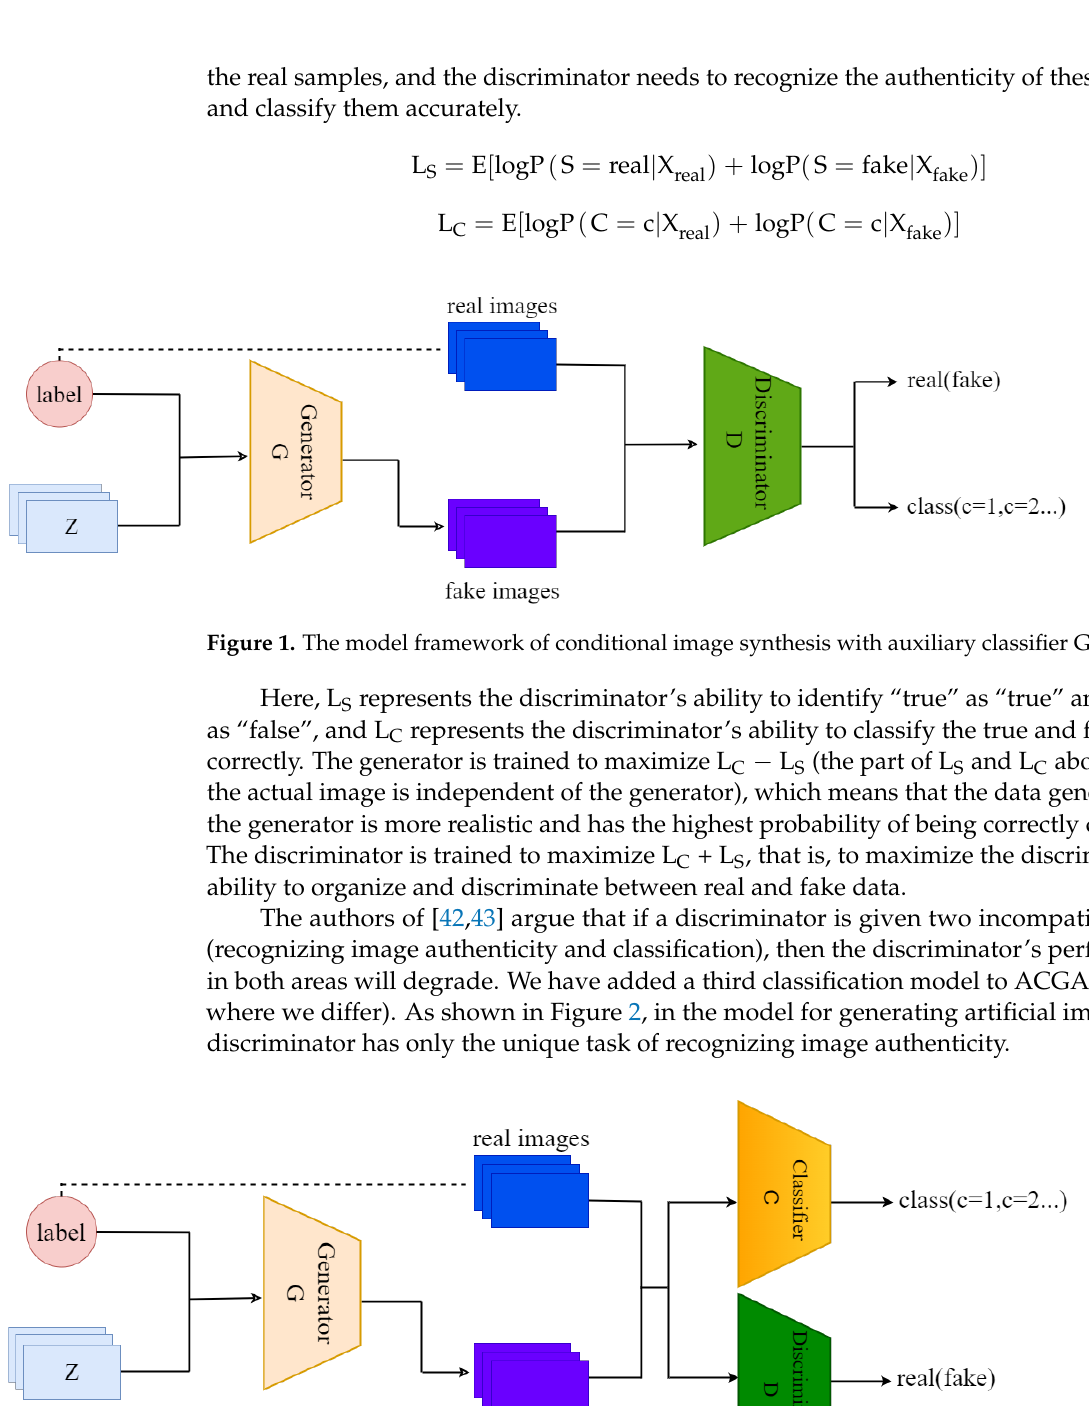
Figure 2. The image generation model framework.